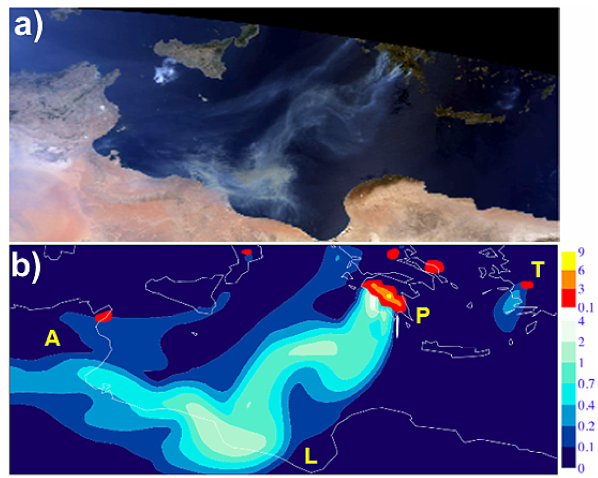
Figure 10. (a) MODIS Terra “true” colour composite derived for 26 August (09:35UTC) and (b) fire-emitted smoke aerosol opti- cal depth at 550nm derived using the modelling scheme detailed in Sect. 5.2 (blue scale) along with SEVIRI-derived FRP-density observations derived from the FRP-PIXEL product (Wm 2 , top, red scale) and interpolated to the atmospheric model grid. The FRP- PIXEL observations indicate the smoke plume sources and high- light the strength of the Peloponnese fires at this time. The Pelopon- nese (P), Libya (L), Algeria (A) and Turkey (T) fires are identified. MODIS data source in (a) :